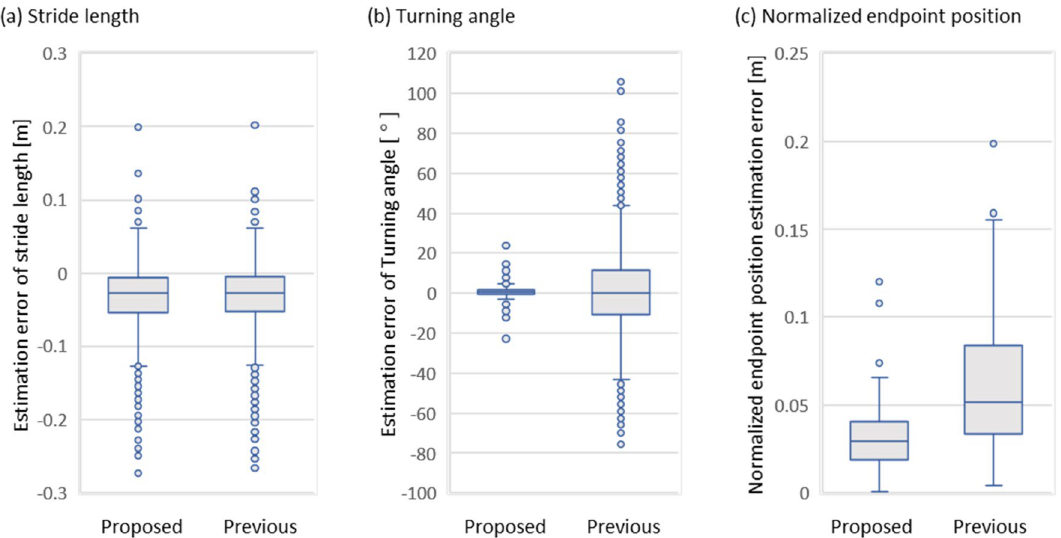
Figure 7. Box plot results in comparison of estimation error of stride length, estimation error of turning angle, and normalized endpoint position estimation error, between the proposed method and the representative previous method.